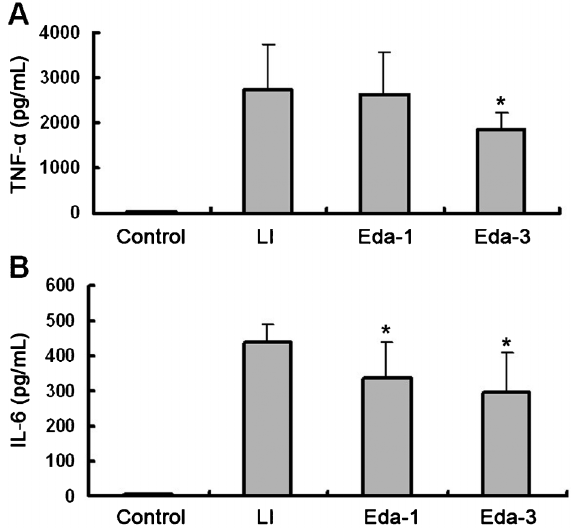
Figure 3. Serum TNF- a and IL-6 levels. LI group: liver injury induced by D-galactosamine and lipopolysaccharide (GalN/LPS); Eda-1 and Eda-3 groups: edaravone at 1 and 3 mg/kg 30 min before and 4 h after GalN/LPS-induced liver injury. Data are reported as means±SD (n=6). *P , 0.05 vs LI group